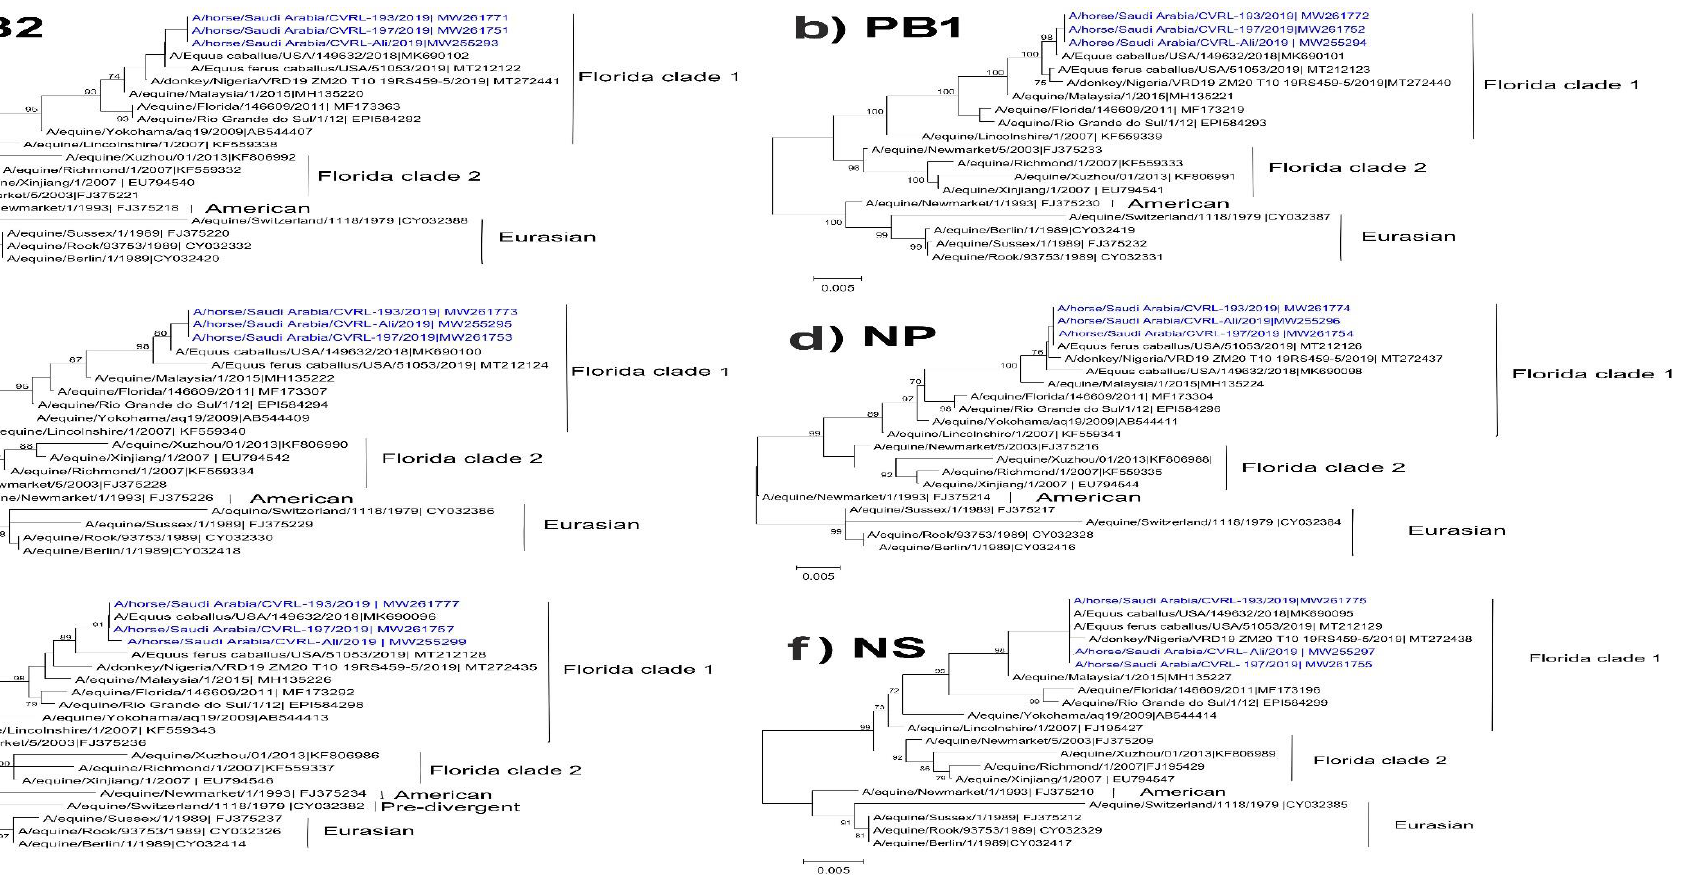
Figure 2. Phylogenetic tree of influenza virus polymerase complex (PB2, PB1, PA), nucleoprotein (NP), matrix protein (M), and non-structural gene (NS) nucleotide sequences of the Saudi H3N8 strains in comparison to representative published sequences. ( a ) ML phylogenetic tree of PB2 gene, ( b ) ML phylogenetic tree of PB1 gene, ( c ) ML phylogenetic tree of PA gene, ( d ) ML phylogenetic tree of NP, ( e ) ML phylogenetic tree of M gene, and ( f ) ML phylogenetic tree of NS gene. Phylogenetic trees were created using the maximum likelihood method with 1000 bootstraps. Saudi strains are presented in blue.